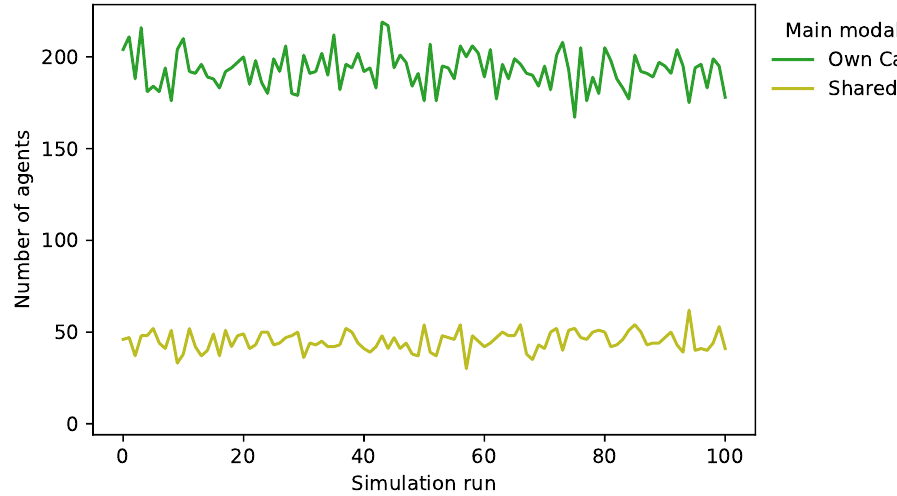
Figure 12. Number of agents that chose one of the two cycling modalities to be the main modality across 100 simulation runs.